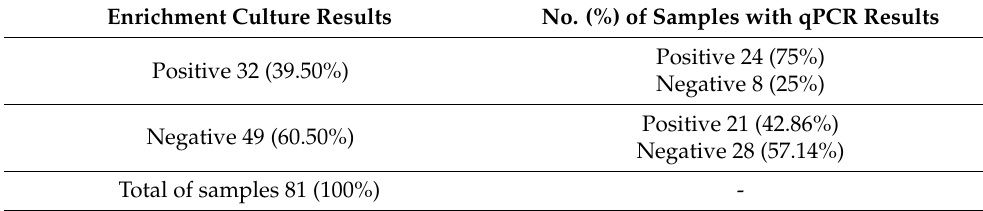
Table 4. Comparison of detected positive or negative results from qPCR assay with CSEC